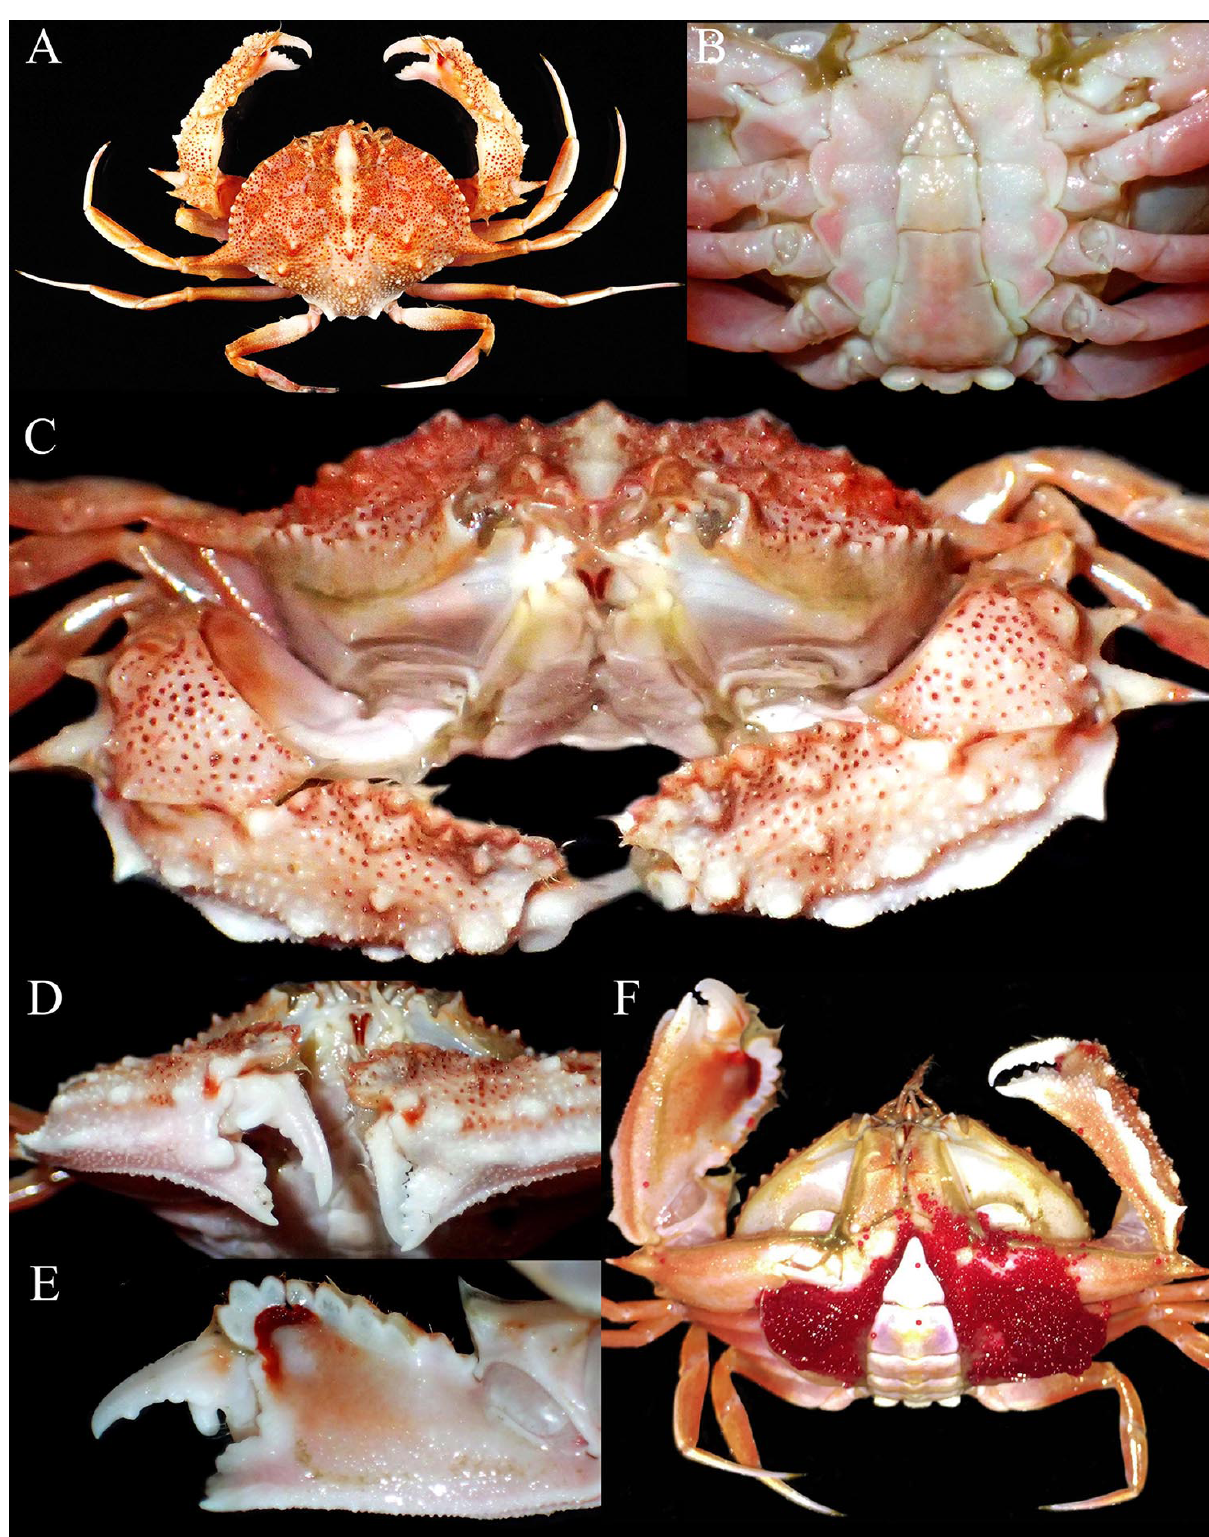
Figure 1. Mursia spiridonovi Karasawa, 2018, color in life. A – E , male (23.9 × 14.6 mm) (ZRC 2019.0492); F , ovigerous female (28.4 x 18.1 mm) (DABFUK). A , overall dorsal view; B , F , thoracic sternum and pleon; C , frontal view of cephalothorax and chelae; D , outer view of chelae; E , inner surface of right chela. Photographs: Chan T.-Y., P. K. L. Ng, Suvarna S.